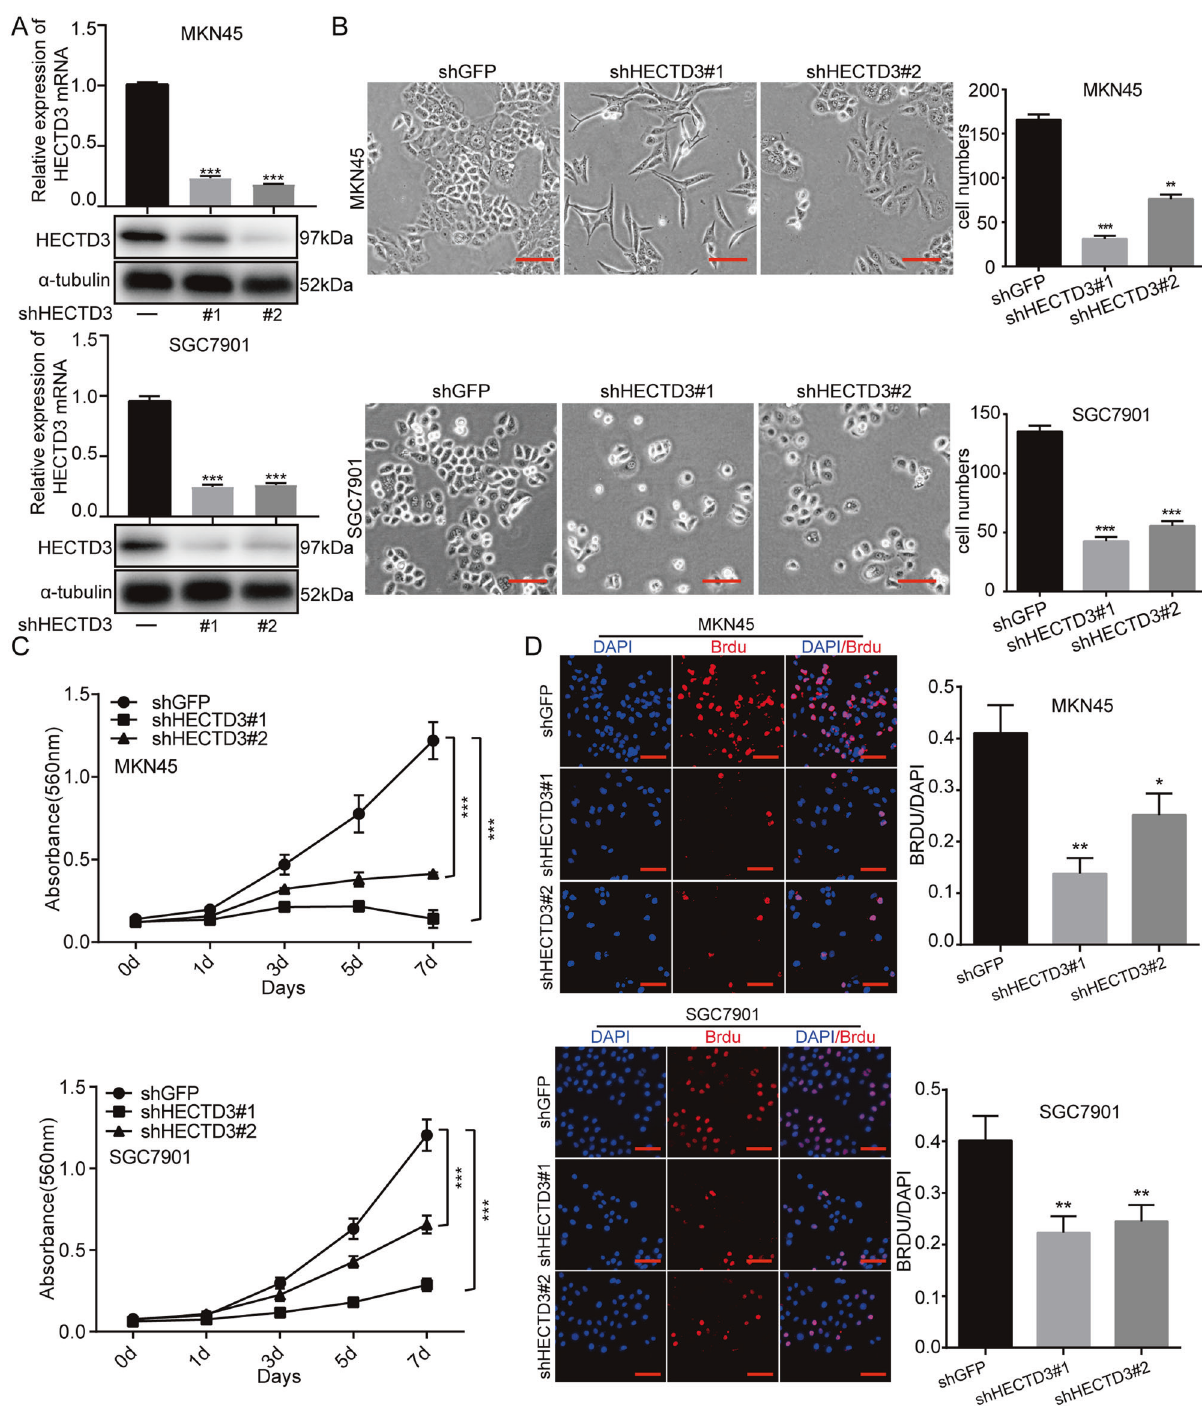
Fig. 2 Depletion of HECTD3 restrains the multiplication of gastric cancer cells. A Quantitative PCR and western blot were adopted to assess level of HECTD3 with HECTD3-knockdown cells. B Morphology and numbers of cells were observed after knocking down HECTD3. C MTT curves of HECTD3 knock down gastric cancer cells. D Cells positive for BrdU staining are shown after knocking down